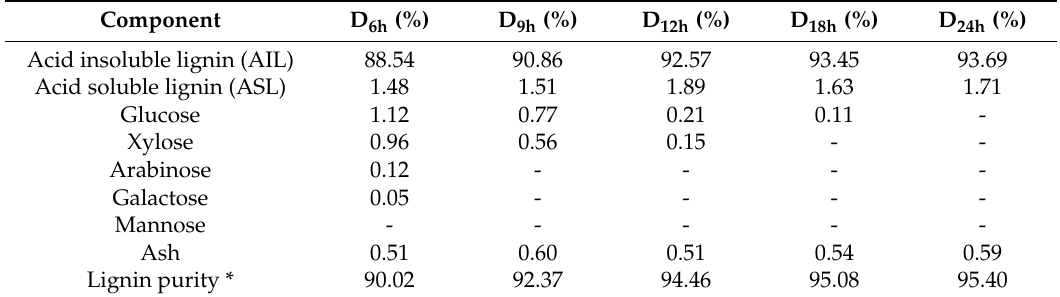
Table 1. Purity of the DES-lignin samples (D 6h , D 9h , D 12h , D 18h , D 24h ) extracted from willow by DES treatment at 120 ◦ C for 6, 9, 12, 18, and 24 h.